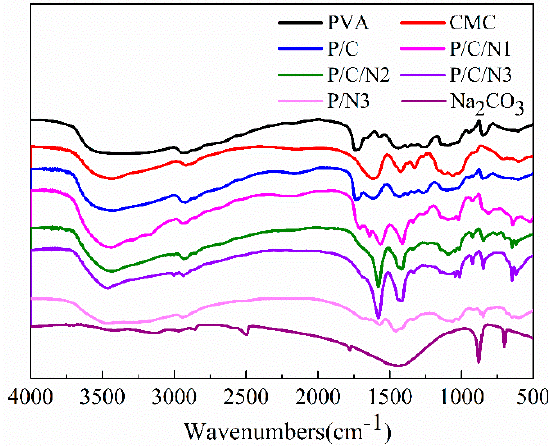
Figure 1. Fourier-transform infrared (FTIR) spectra of Na 2 CO 3 and the obtained composite films.